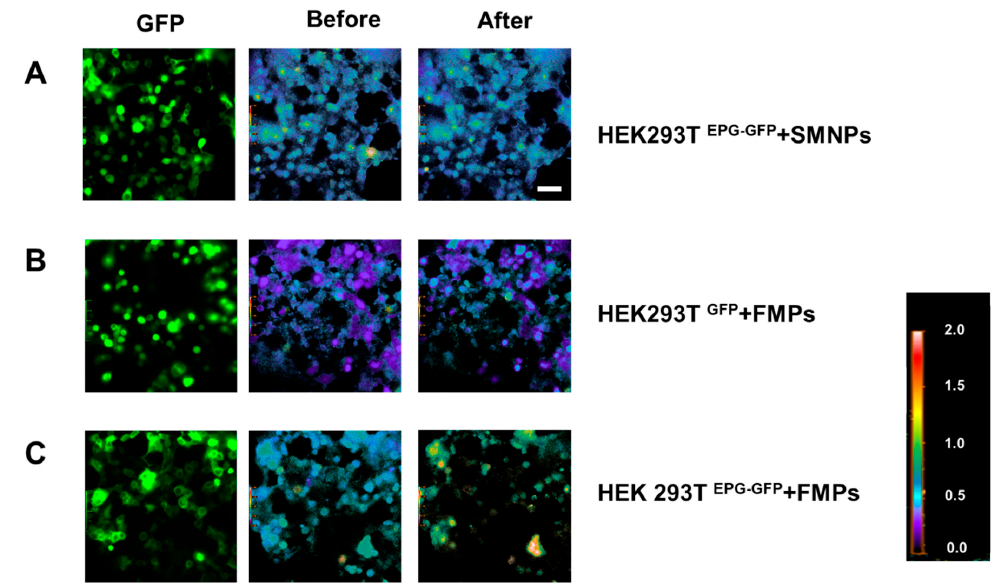
Figure 4. Calcium ion imaging following stimulation with different types of magnetic particles. Images of [Ca 2+ ] i in EPG+GFP-transfected HEK293T cells (the original GFP images: left column, of [Ca 2 + ] i in EPG + GFP-transfected HEK293T cells (the original GFP images: left column, 340 / 380 ratio 340/380 ratio pseudo-images before adding MPs: middle column, 340/380 nm ratio image after the pseudo-images before adding MPs: middle column, 340 / 380 nm ratio image after the addition of MPs: addition of MPs: right column, 20×). ( A ) HEK293T EPG+GFP with SMNPs. ( B ) HEK293T GFP with right column, 20 × ). ( A ) HEK293T EPG + GFP with SMNPs. ( B ) HEK293T GFP with Ferromagnetic particles (FMPs). ( C ) HEK293T EPG + GFP with